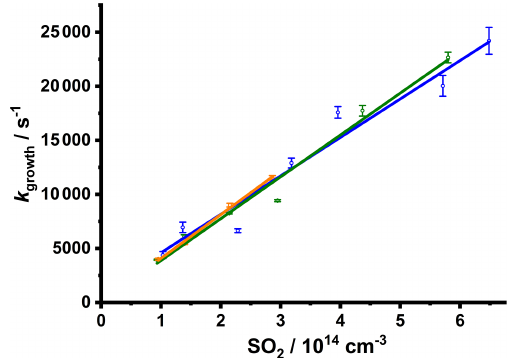
Figure 7. Time-resolved absorbance signals for SO 3 obtained at Figure 8. Bimolecular plots of the pseudo-first-order rate coeffi- a wavenumber of ∼ 1388 . 7cm − 1 . Data are averages of 250 pho- cients, k growth , determined from the observed SO 3 profiles as a tolysis shots at a total pressure of 50Torr at 298K with [SO 2 ] function of [SO 2 ]. Data were obtained at total pressures of 20Torr = 2.1 × 10 14 cm − 3 and [CH = 1.6 × 10 14 cm − 3 . The fit to (blue points and line; giving k 5 = (3.55 ± 0.35) × 10 − 11 cm 3 s − 1 , 2 I 2 ] Eq. (3) to determine the kinetics describing the production and intercept = (1000 ± 1400s − 1 )) , 50Torr (green points and line; giv- loss of SO 3 (red) gave k growth = (8250 ± 60)s − 1 and k loss = ing k 5 = (3.87 ± 0.28) × 10 − 11 cm 3 s − 1 , intercept = (100 ± 900 s − 1 )) , and 100Torr (orange points and line; giving k 5 = (300 ± 10)s − 1 . (4.05 ± 0.19) × 10 − 11 cm 3 s − 1 , intercept = (400 ± 400s − 1 )) . The data compare well to the current IUPAC recommendation of (cid:16) (cid:17) × 10 − 11 cm 3 s − 1 (Cox et al., 2020). Error bars are 1 σ 3 . 70 + 0 . 45 − 0 . 40 from the fits to Eq.